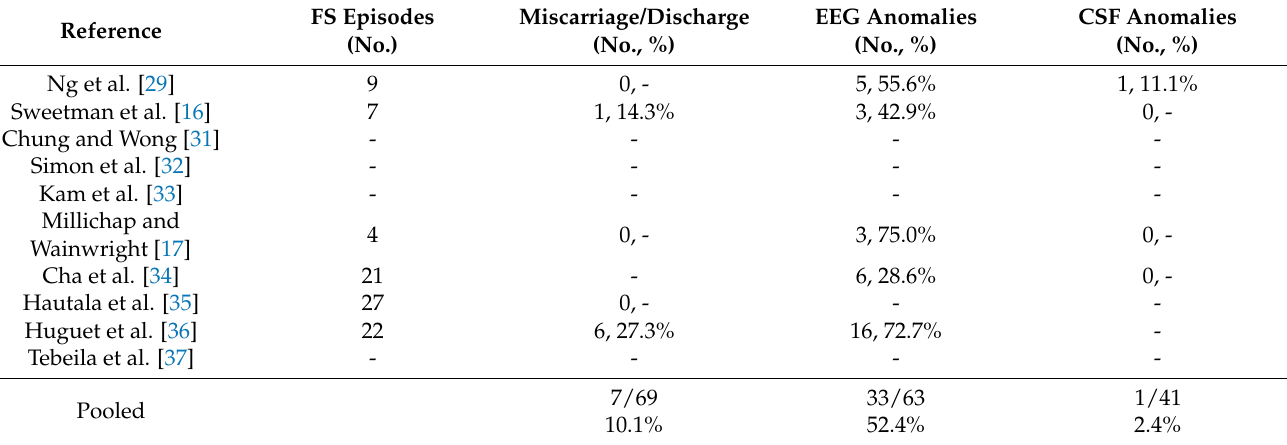
Table 3. Main characteristics of the febrile seizures (FS) episodes included in the